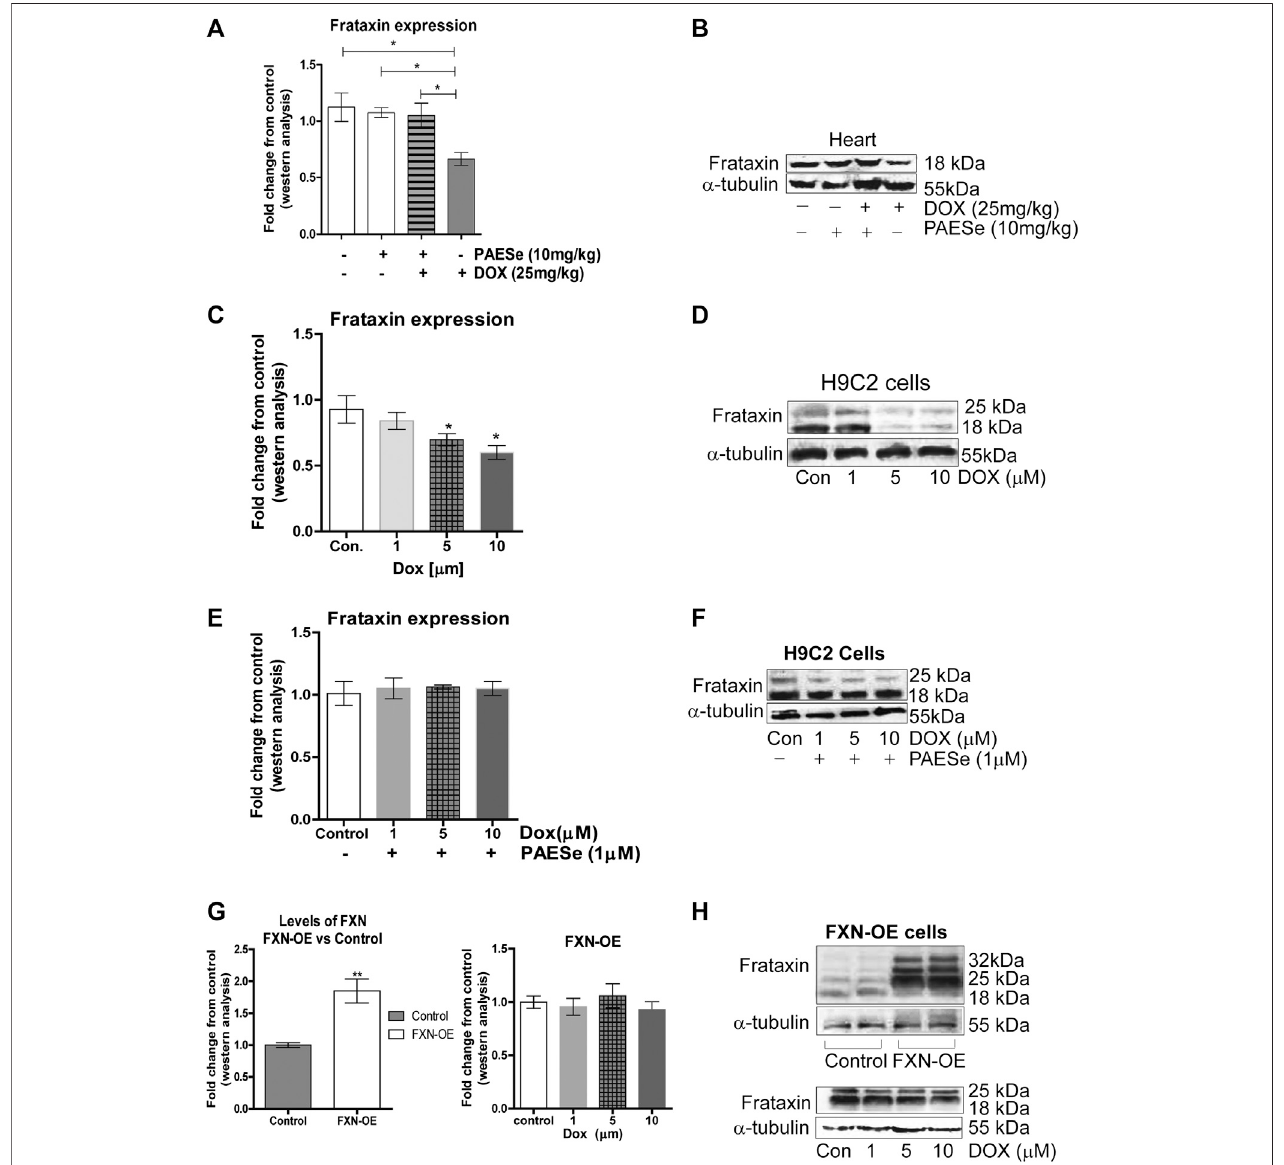
FIGURE 3 | PAESe prevents DOX-mediated reduction of frataxin expression. (A,B) Western blot analysis of frataxin expression levels from heart tissue from cumulative dosing of DOX (25 mg/kg) ± PAESe (50 mg/kg/dose) as described in the methods section. Animals were administered drugs once a week (Q.I.W.), and the dosing stopped at the 4th weeks. (* p < 0.05; ** p < 0.001, *** p < 0.0001; Mean ± SEM, n (cid:2) 3x4) (C,D) Western blot on H9C2 and (E – H) Frataxin over expressing (OE) H9C2cardiomyobalstscelllines.BothH9C2andFrataxinoverexpressingcellsweretreatedwithdrugfor24 hascontrol(media),DOX(1 μ m,5 μ m,or10 µm)with or without PAESe (1 µM). (* p < 0.05,** p < 0.001, *** p < 0.0001 vs Control; Mean ± SEM, N (cid:2)